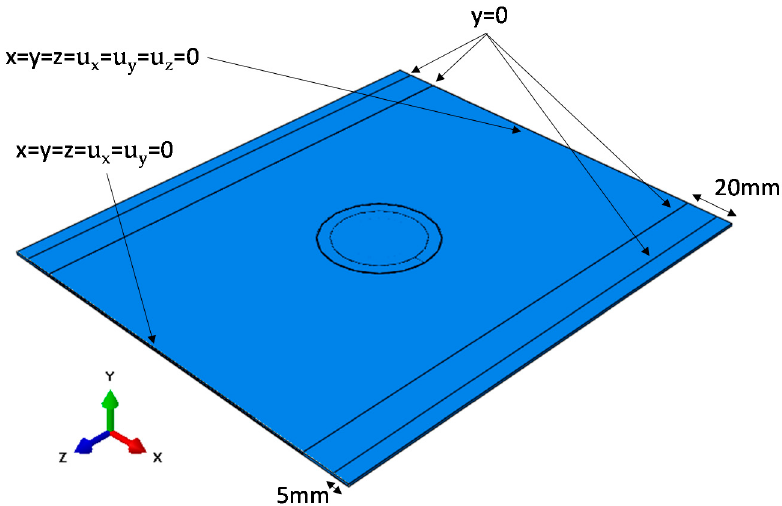
Figure 1. Illustration of rods that were placed onto the upper and bottom faces of the laminate.